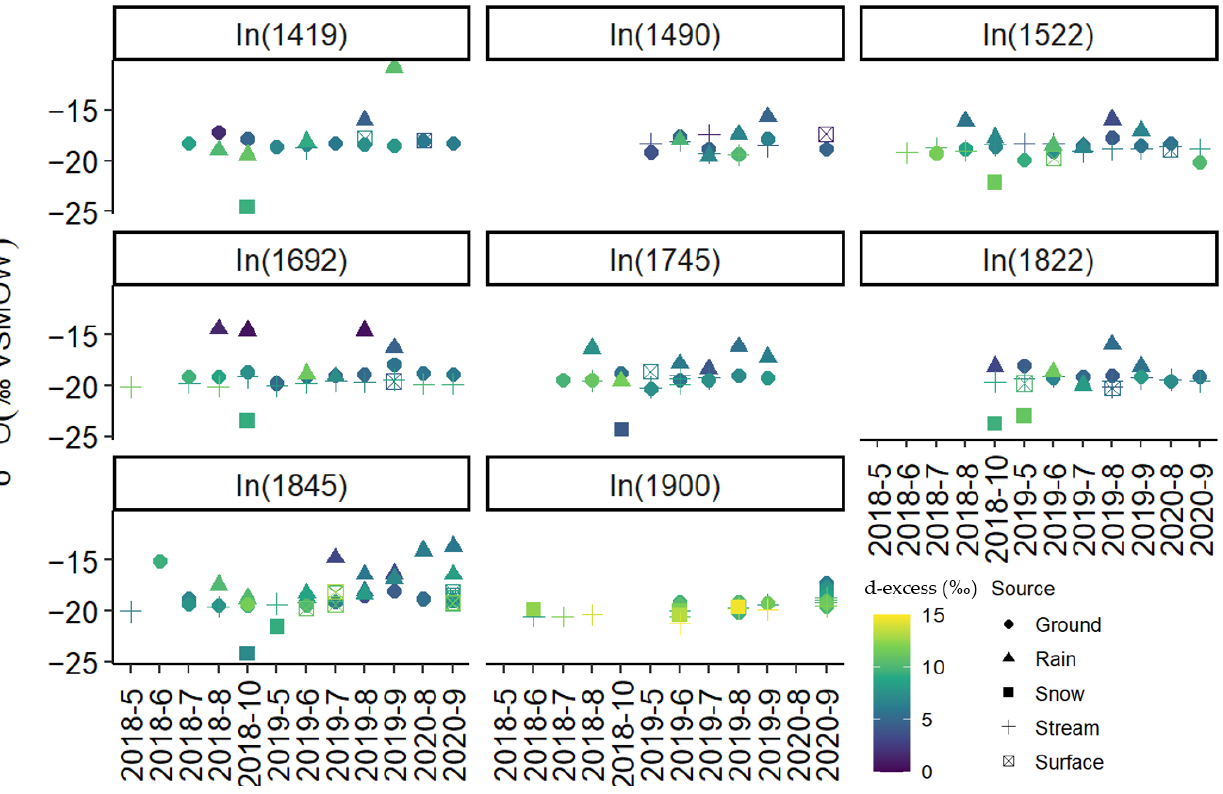
Figure 7. Spatiotemporal plot of δ 18 O and d-excess for all intensive sites throughout the 2018 and 2019 growing seasons. D-excess is depicted by color and source waters are distinguished by symbol for groundwater, rain, snow, stream, and surface water.